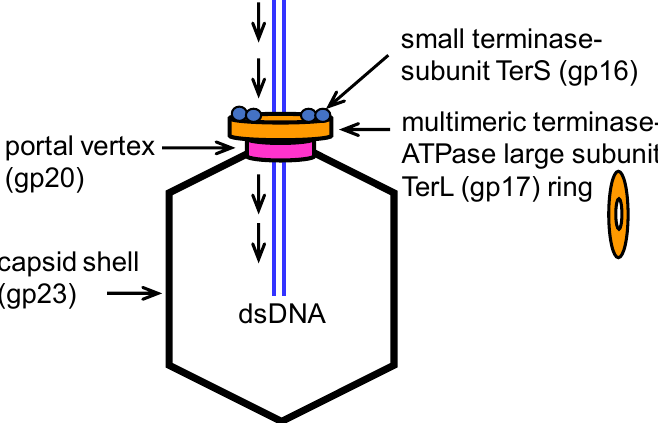
Figure 1. Conserved bacteriophage two subunit terminase prohead packaging; large terminase-ATPase subunit TerL (T4 gp17) only packages linear DNAs in vitro; small terminase subunit TerS (T4 gp16) required in vivo for concatemer (or circular DNA) packaging.